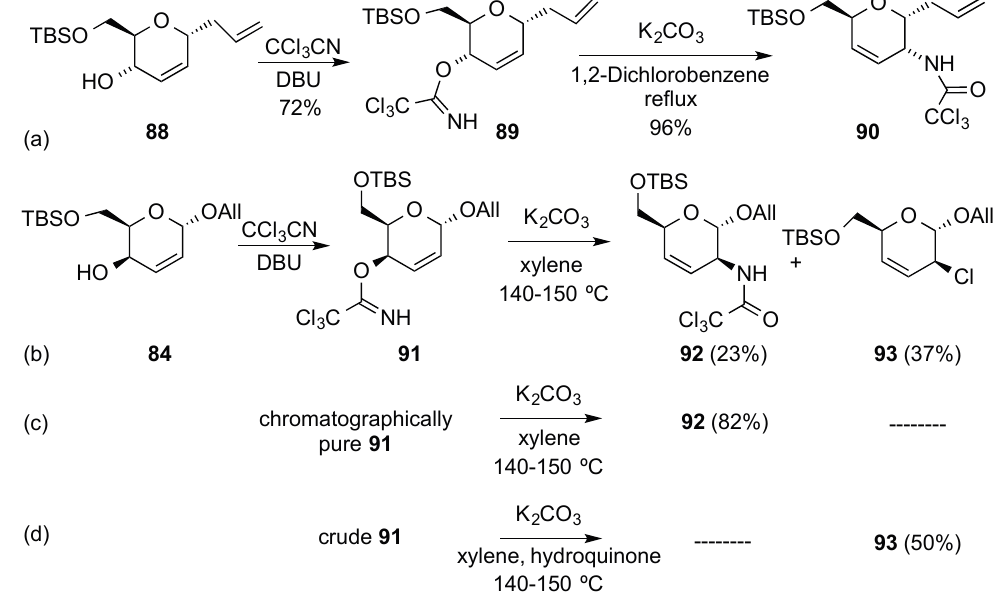
Scheme 21. Examples of Overman